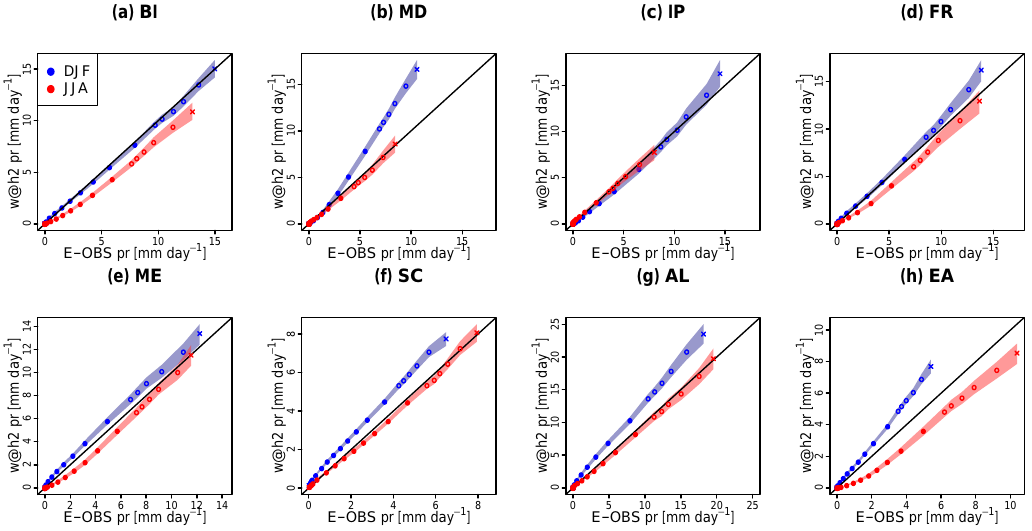
Figure 12. Same as Fig. 11 but for daily precipitation: quantile–quantile plots for JJA (red) and DJF (blue) comparing w@h2 to E-OBS over years 1950–2006. Here, the same axes are used for both